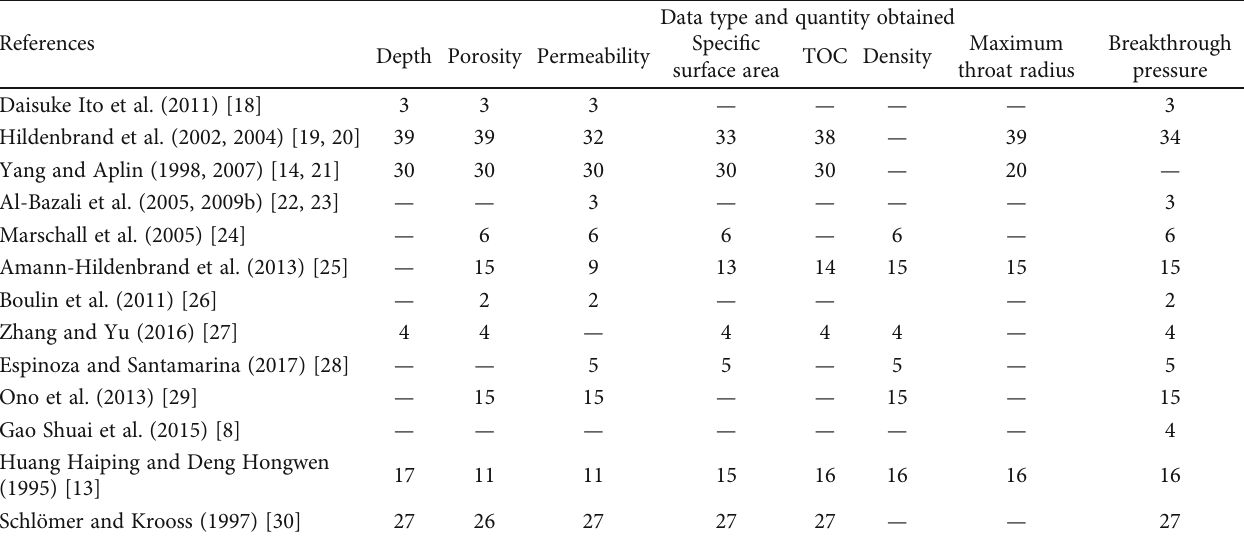
Table 1: Mudstone breakthrough pressure test data obtained through literature review.